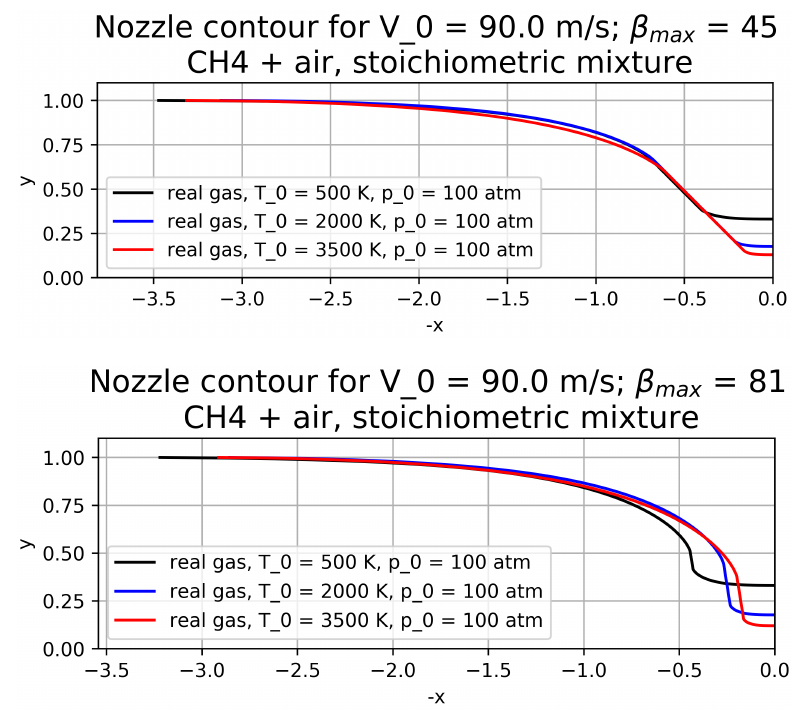
Figure 5. Nozzle contours.